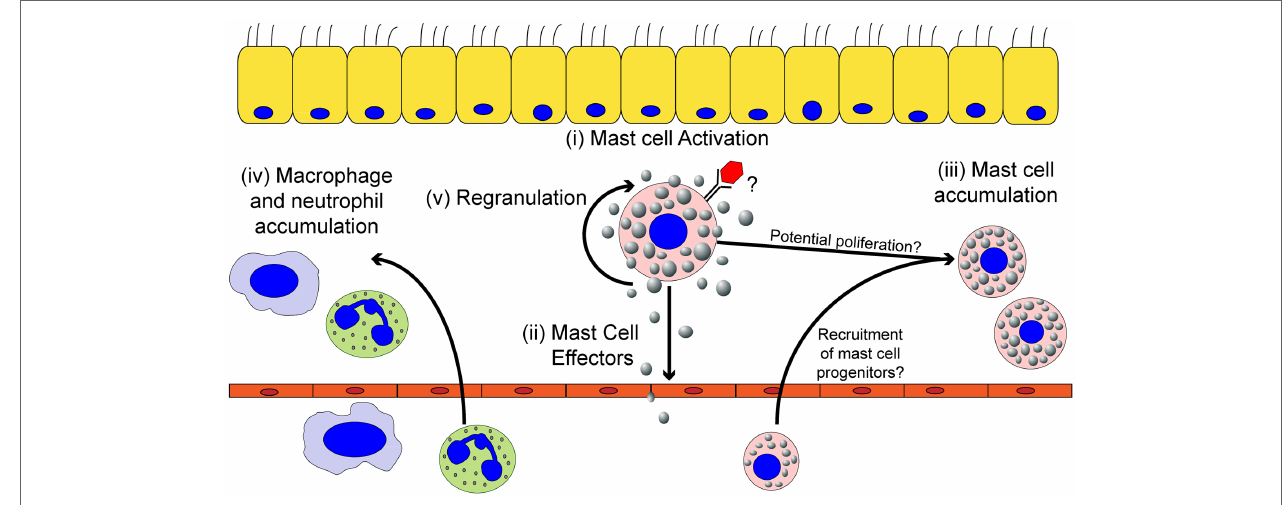
progenitors to the infected tissue and/or proliferation of the tissue-resident mast cell population. Mast cell activation can participate in limiting viral replication in the local tissue and viral dissemination, but if left unchecked can cause significant tissue damage, vascular leakage, and tissue edema. Finally, activated mast cells can survive the pathogenic insult and replenish mast cell granules to return the mast cell to a basal state to survey the tissue for future pathogenic insults